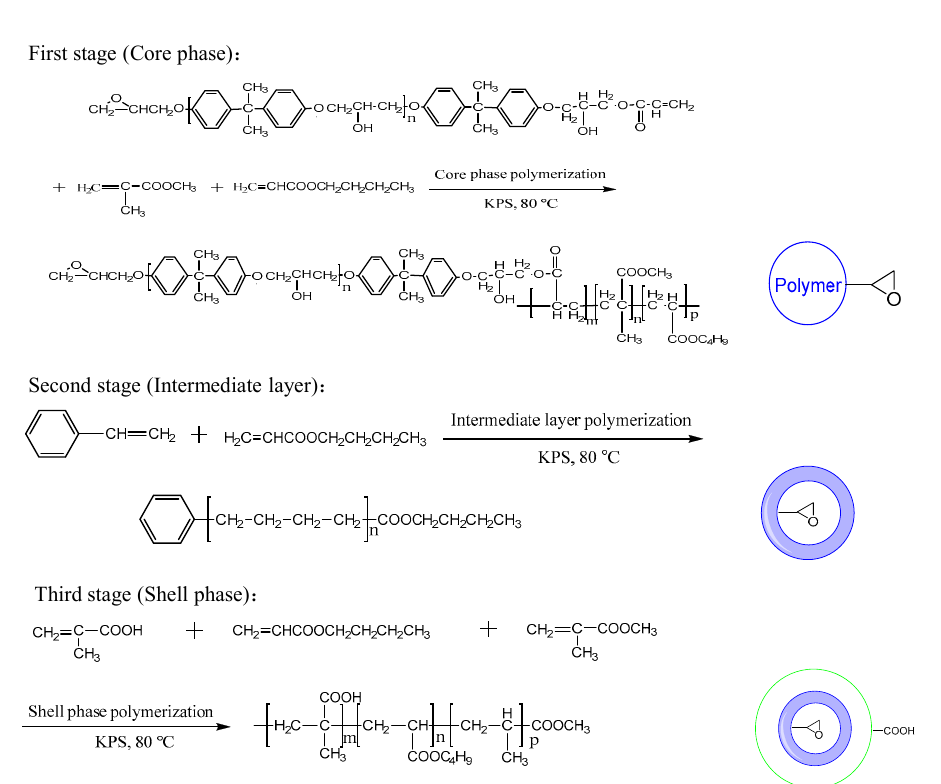
Figure 2. Schematic of waterborne epoxy-styrene-acrylate composite latex with a “core-intermediate-shell” three-layer structure.